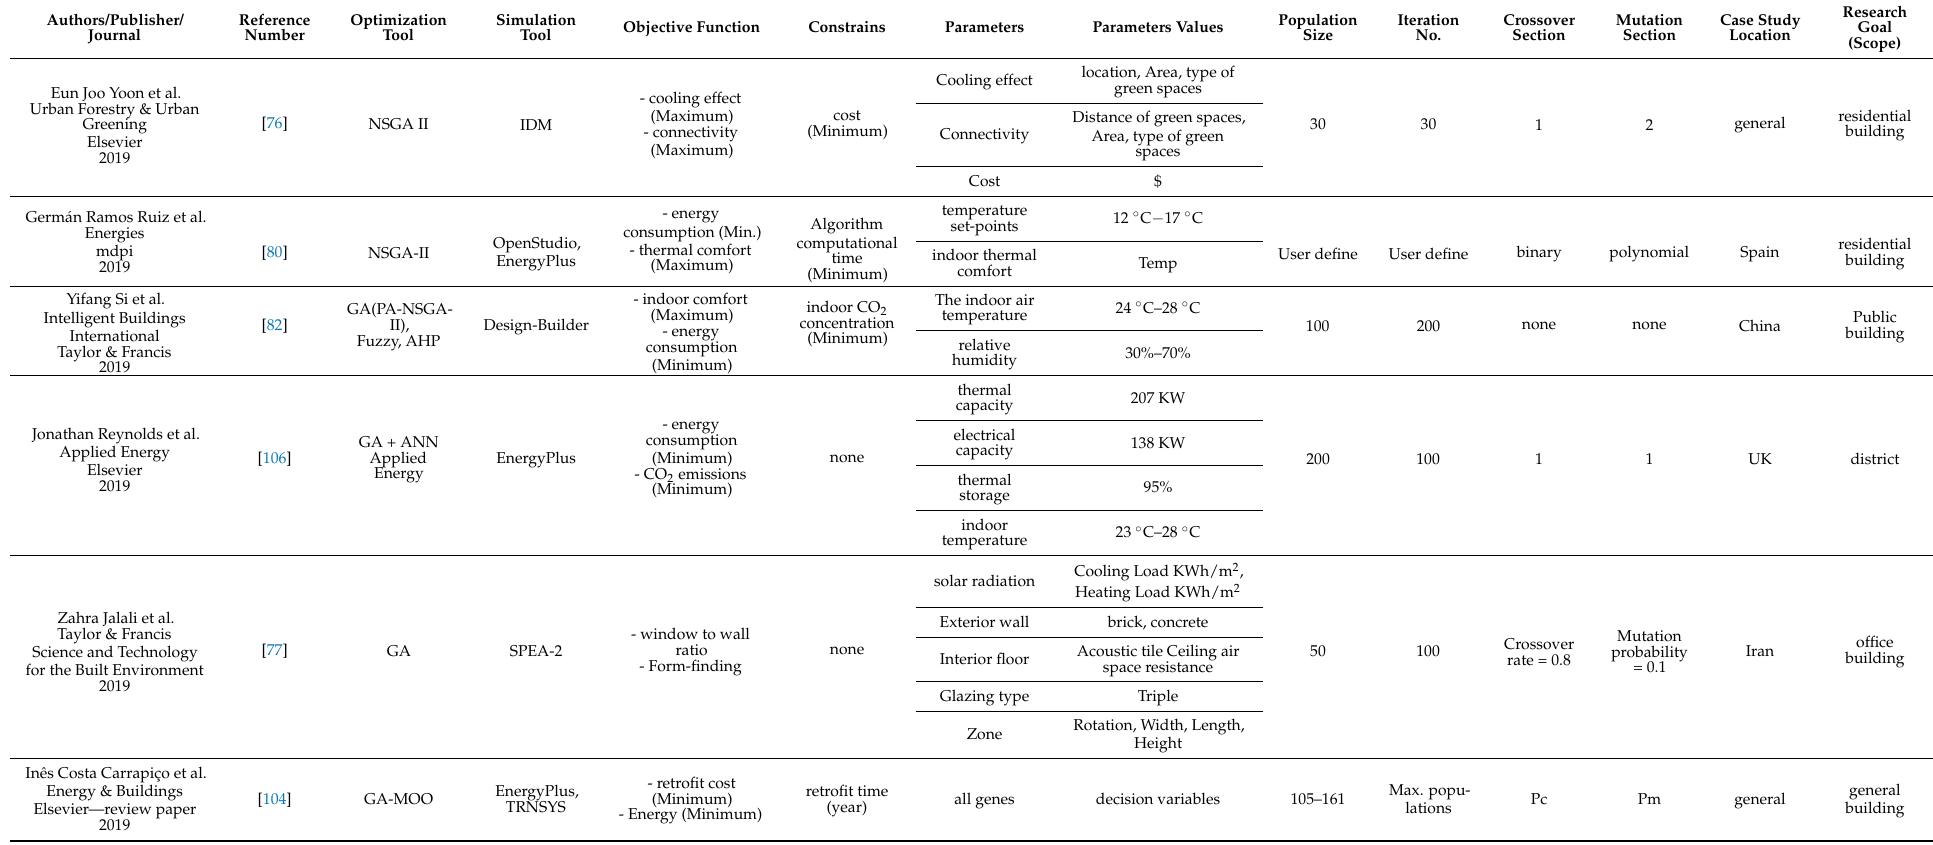
Table 2. Extraction of data studies for analysis, and GA